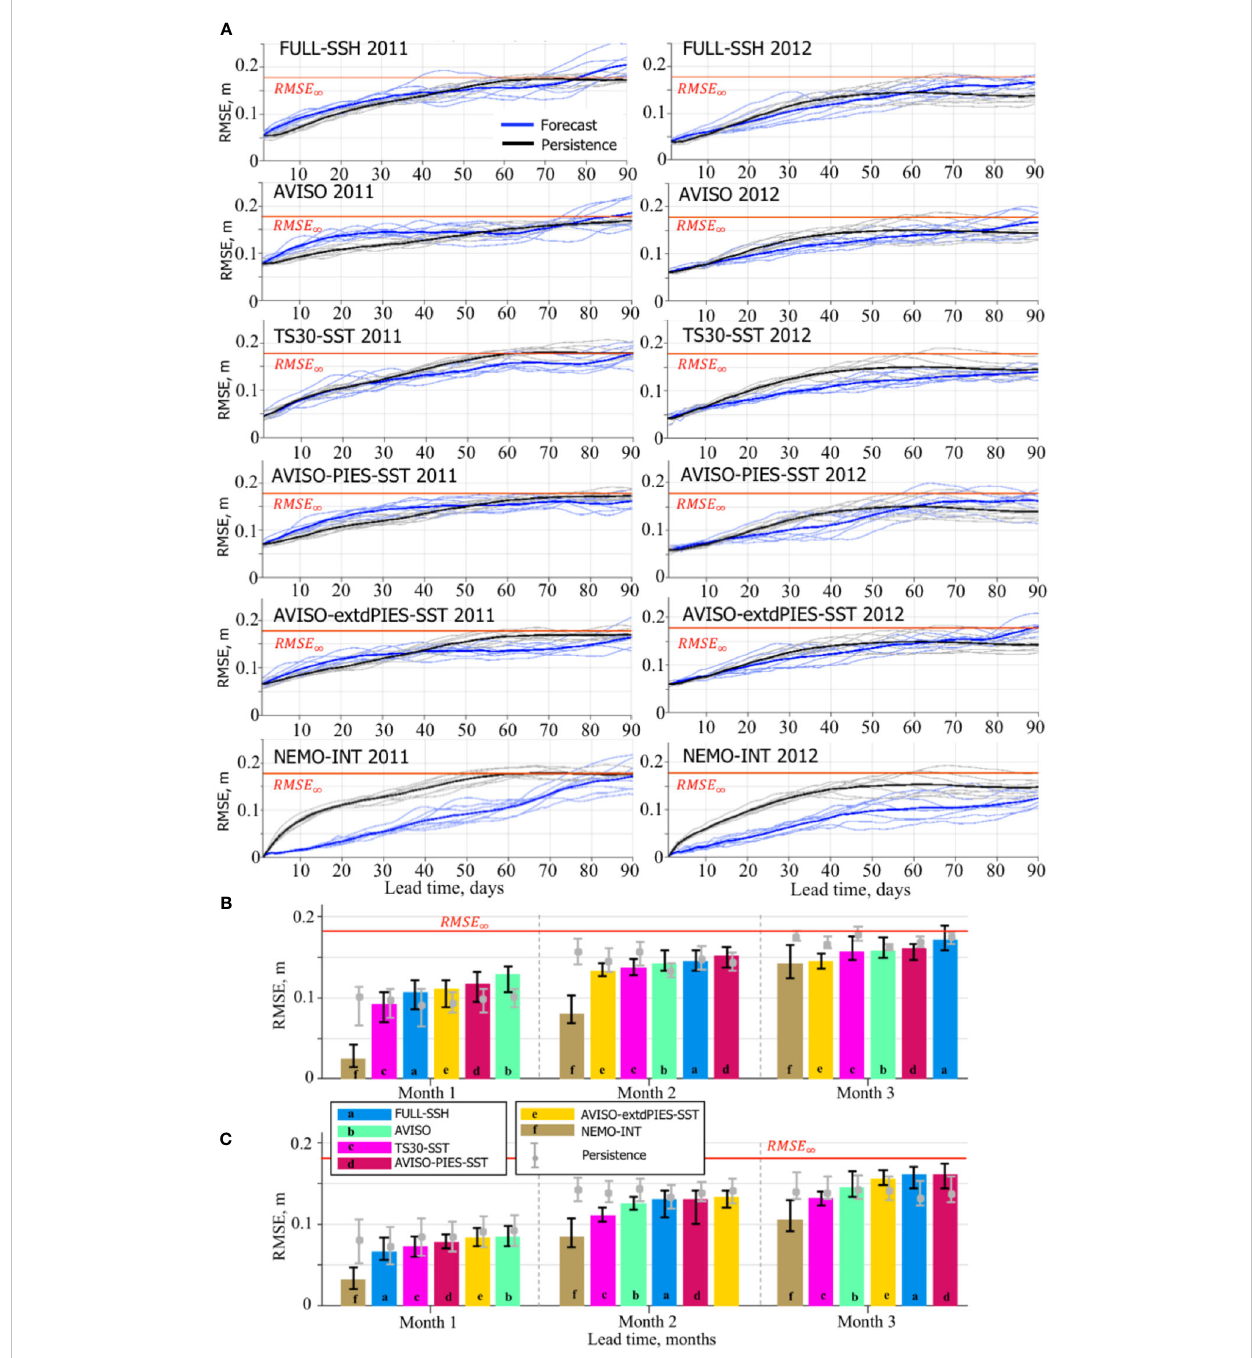
FIGURE 13 RMSE between SSH from the OSSE forecasts and the NR. (A) Daily RMSE for individual forecasts and persistence from the OSSE forecast groups during 2011 (left column) and 2012 (right column). The bold solid lines are the mean RMSE estimates for the forecasts (blue) and persistence (black). The horizontal red line indicates 95% of the saturation value ( RMSE ∞ = 0.178 m). The bar diagrams (B, C) show median RMSE (m) of the forecasts by the OSSE forecast groups during months 1 through 3 started in May-June 2011 (B) and January-February 2012 (C) . Within each month, the OSSE forecast groups are ordered according to the ranks based on the median RMSE. The vertical black lines on top of the bars indicate the IQR. The grey line and the bullet show the IQR and the median, respectively, of the persistence corresponding to the OSSE forecast group. The horizontal red line indicates RMSE ∞